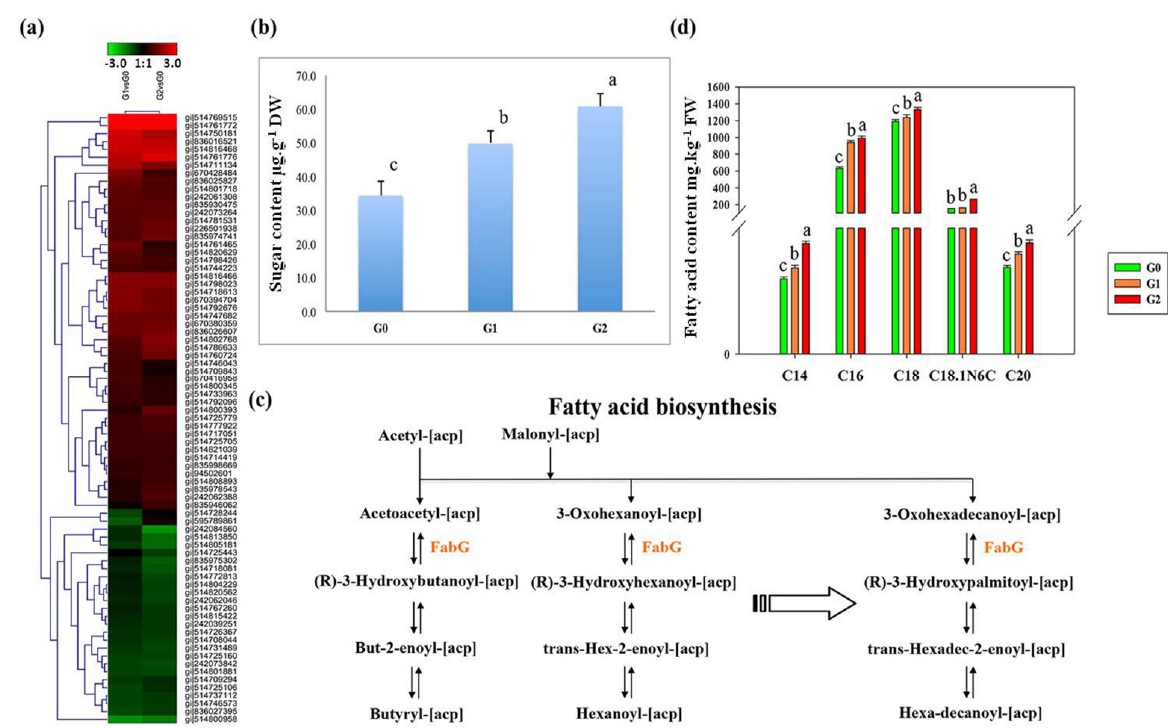
Figure 5. Drought-induced DAPs participate in the biosynthesis of sugars and fatty acids. ( a ) Heat map of DAPs related to energy metabolism. ( b ) Sugar content in the G0 control, G1 and G2 groups. ( c ) Fatty acid biosynthesis pathway. ( d ) Fatty acid content (five different examples) in the control (green), G1 (orange), and G2 (red) groups. The content of each sugar and fatty acid was measured in triplicate, and the data are means ± standard deviations. Different superscript letters indicate significant differences ( p < 0.05) between the drought treatments and control. DW = dry weight. FW = fresh weight. One of the key DAPs associated with fatty acid biosynthesis that was upregulated in response to drought was FabG (Figure 5c). We therefore measured the content of several fatty acids by GC ‐ MS, revealing significant increases in the levels of C16 and C18 fatty